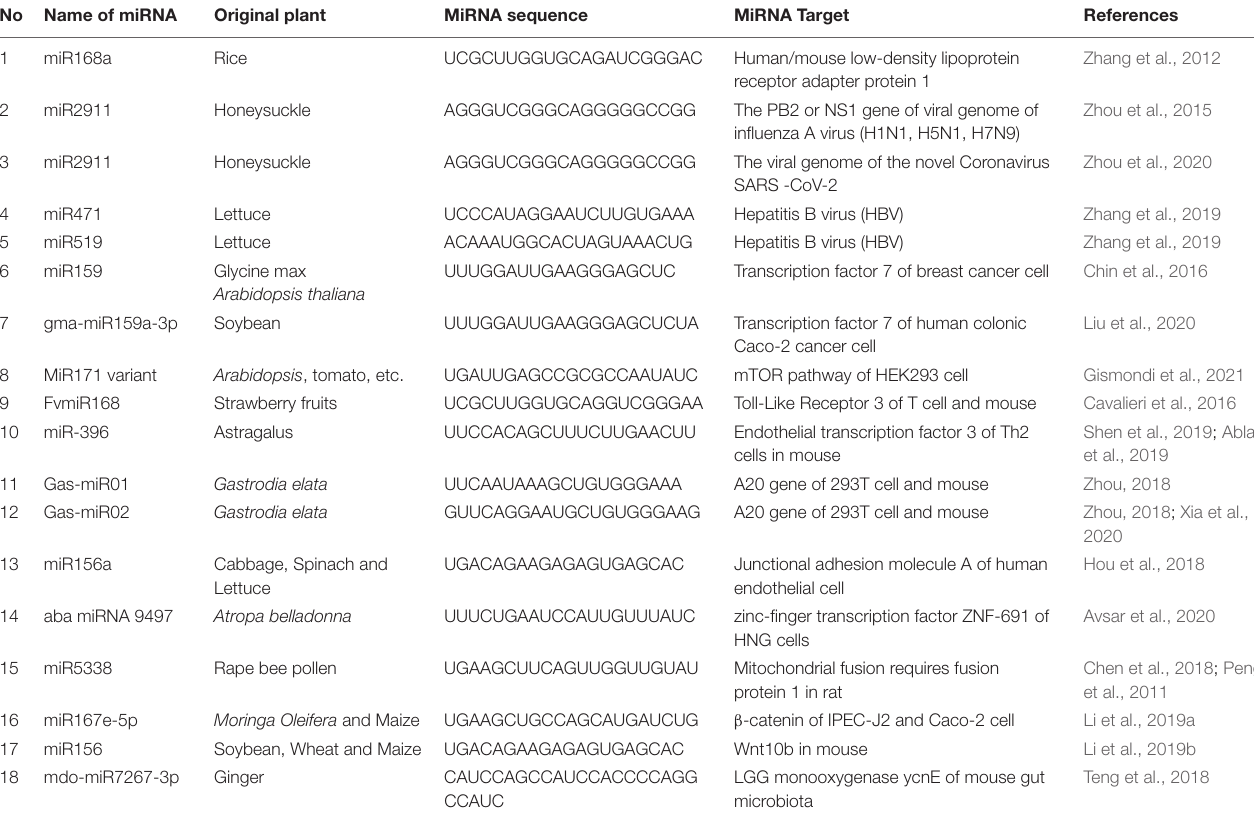
TABLE 1 | Detailed information on plant-derived miRNAs with cross-kingdom activity in